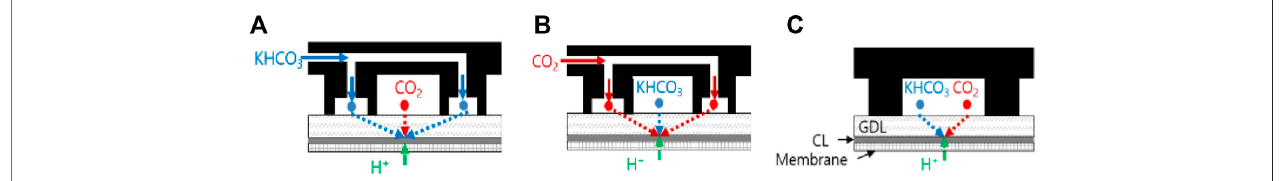
FIGURE 8 | Schematic diagrams of (A) the dual- fl ow type cell with gas in the main channel [Dual (gas)-B], (B) the dual- fl ow type cell with liquid in the main channel [Dual (liq)-B], and (C) the single-channel type cell [Single (mix)-B].